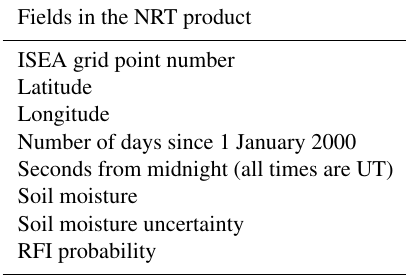
Table 1. SMOS near-real-time (NRT) soil moisture (SM) processor output